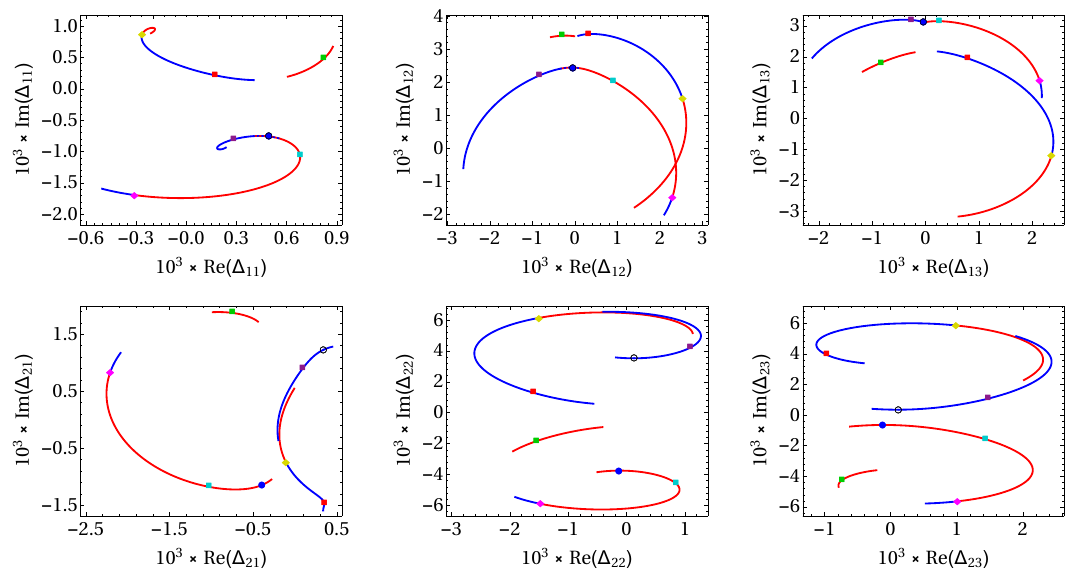
Figure 4 . (Color online) The values of the Yukawa couplings (cid:1) 1 and (cid:1) 2 in the complex plane for the (cid:12)xed values of (cid:21) D = 1 and M R (cid:24) m 4 = 10 10 GeV. The Higgs parameters correspond to the benchmark point B1, table 3. The normal hierarchy is assumed. The colors of the curves correspond to the colors of the solutions in (cid:12)gure